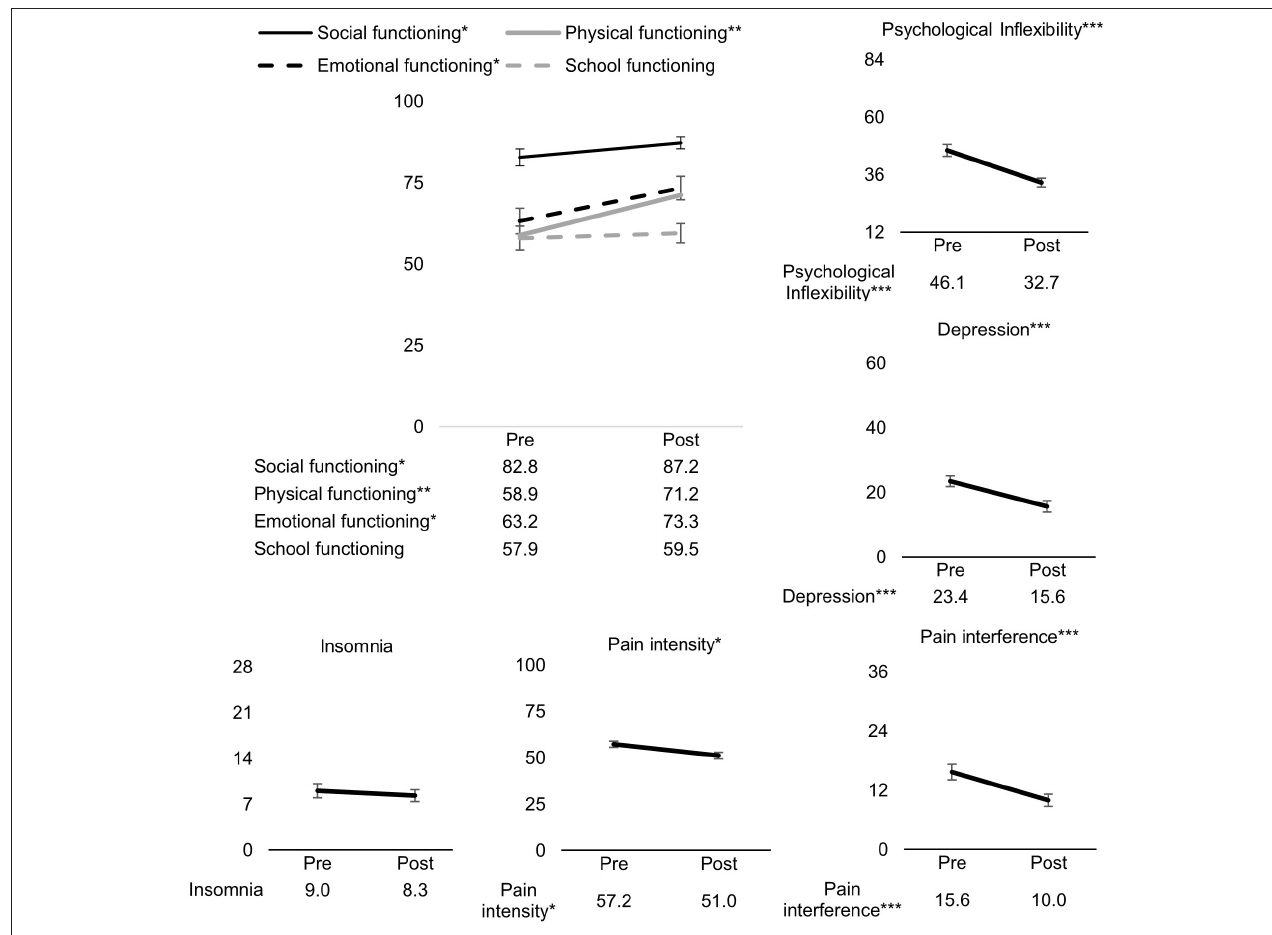
FIGURE 2 | Pre- to post-ACT changes for all outcome measures. Values on the y -axes are mean scores pre- and post-ACT. Errors bars represent standard error of the mean. *** p < 0.001, ** p < 0.01, * p <